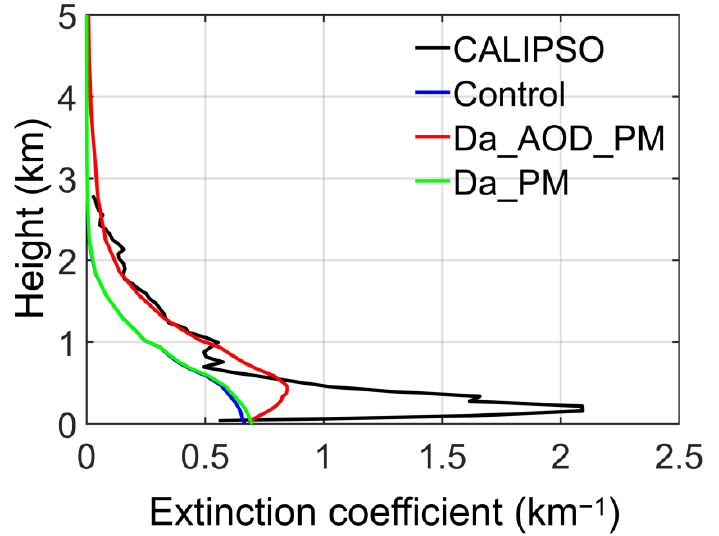
Figure 6. The averaged AEC profile along the line shown in Figure 1b of CALIPSO measurements (black line), the control IC (blue line), Da_AOD_PM analysis (red line), and Da_PM analysis (green line).